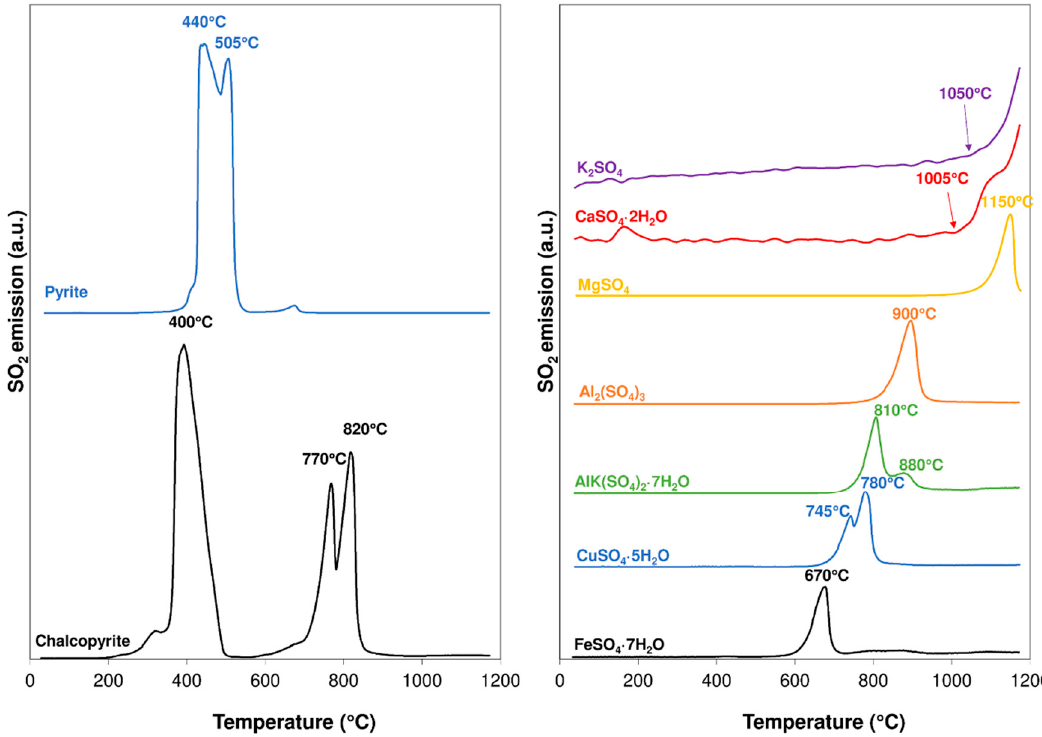
Figure 4. SO 2 emission evolution of analyzed samples.